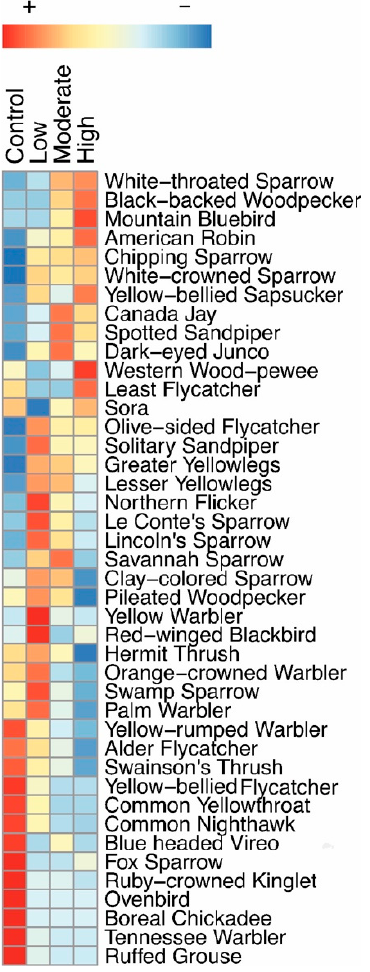
Figure 3. Heatmap of standardized species’ counts in each burn severity category. Colors from blue (never present) to red (most frequently present) represent the relative frequency each species was detected in each severity category.